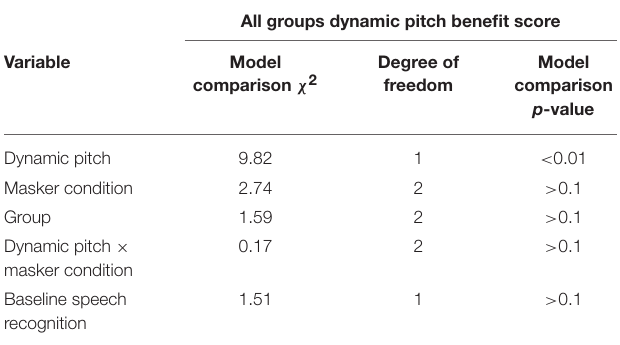
TABLE 2 | Model comparison χ 2 and p -values for dynamic pitch benefit across all three groups ( n =